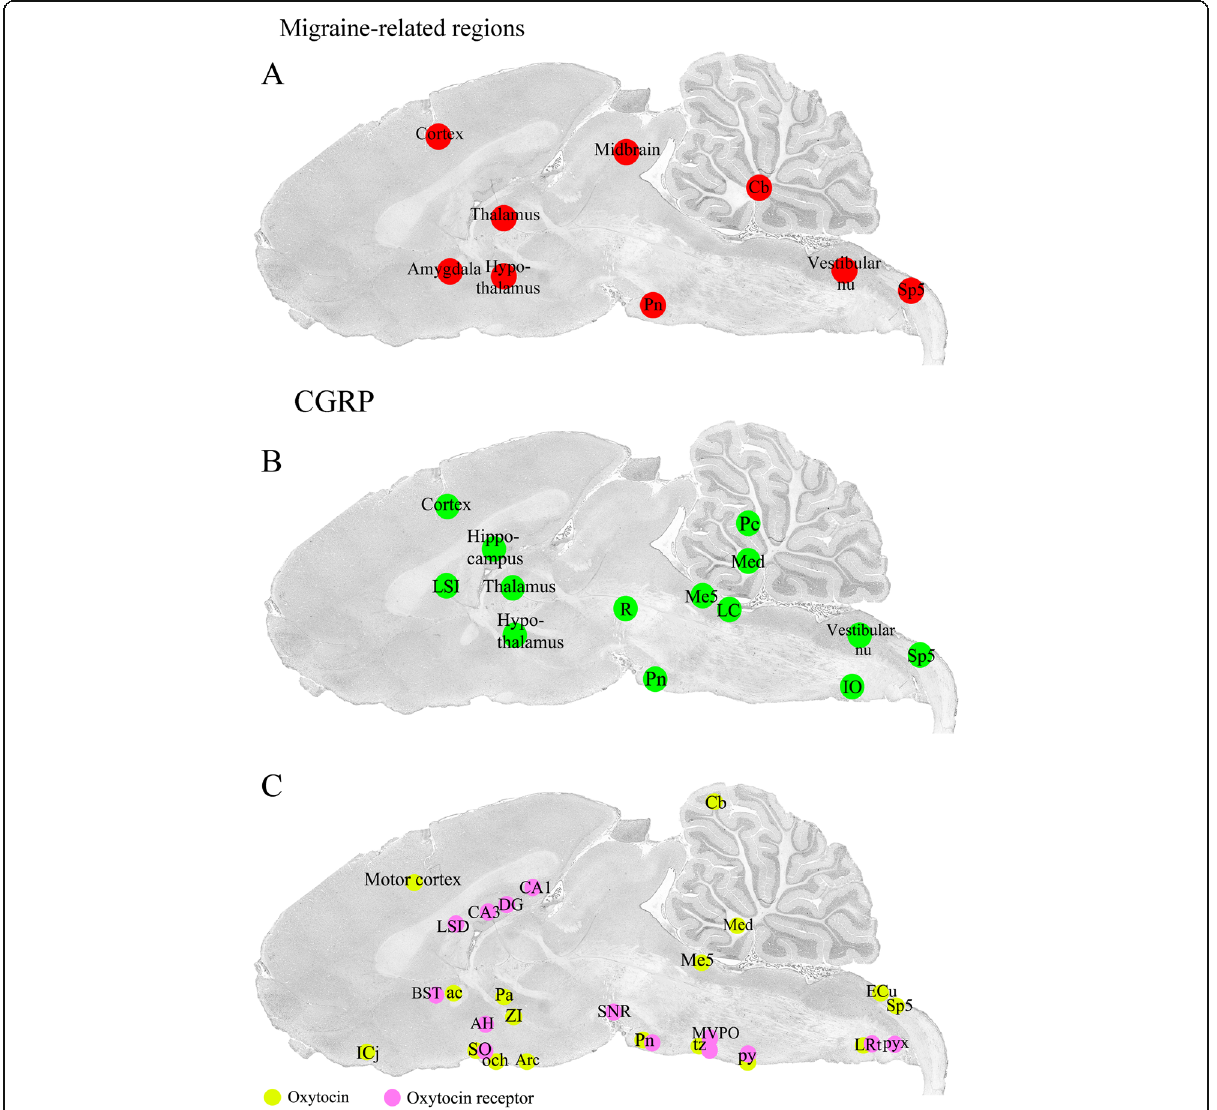
Fig. 1 Sagittal cryo-sections stained with Hematoxylin and Eosin. The 6th edition of The Rat Brain in Stereotaxic Coordinates by Paxinos and Watson [20] was used to identify the different areas. a Migraine related regions. b CGRP distribution. c Oxytocin and oxytocin receptor expression. Yellow color denotes oxytocin and pink oxytocin receptor